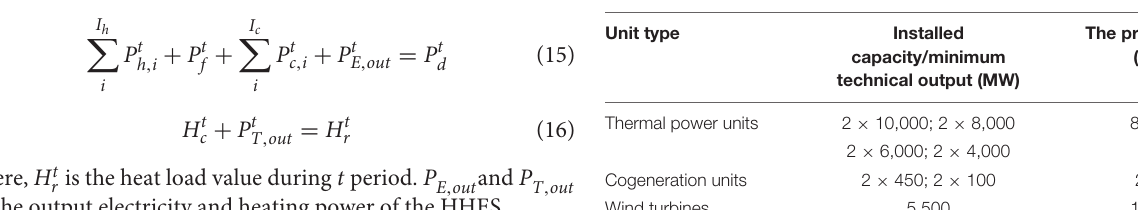
TABLE 2 | Grid installed